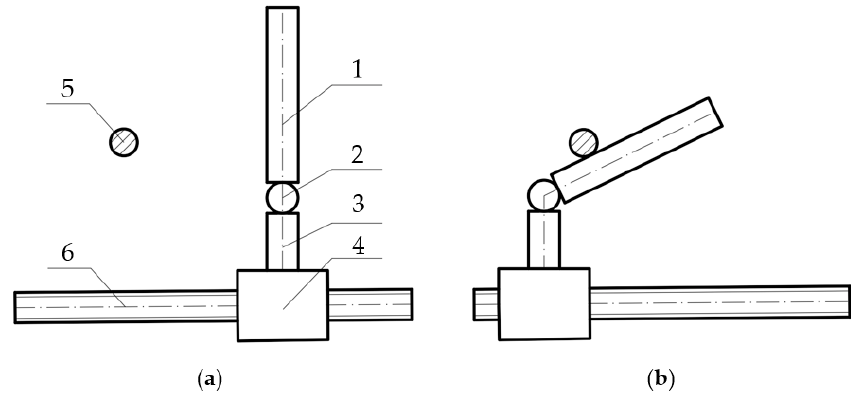
Figure 8. Collapsing process of scale ( a ) the stand state ( b ) the folded state (1—upper section, 2—shaft, 3—lower section, 4—base, 5—stopping bar, 6—ball screw).